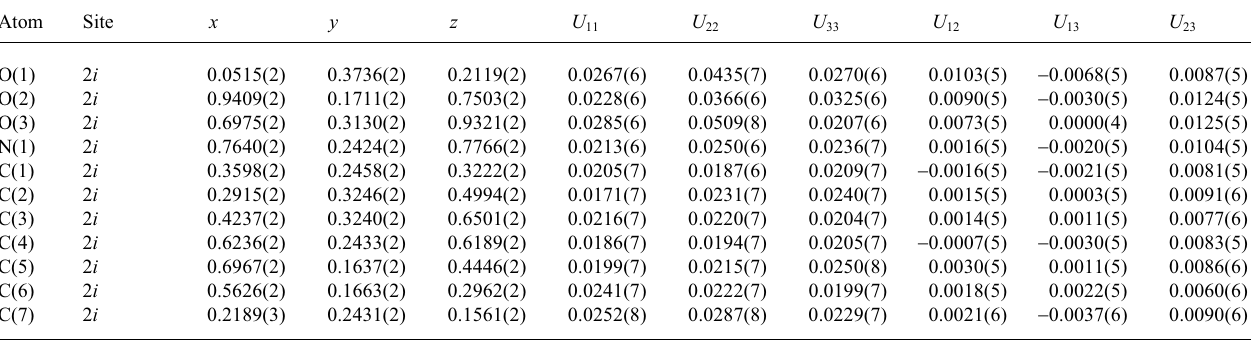
Table 3. Atomic coordinates and displacement parameters (in Å 2 )